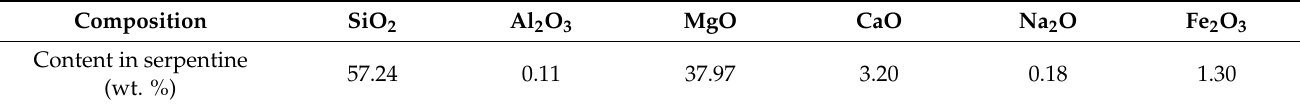
Table 3. The main components and content of serpentine. Composition SiO 2 Al 2 O 3 MgO CaO Na 2 O Fe 2 O 3 Content in serpentine (wt.